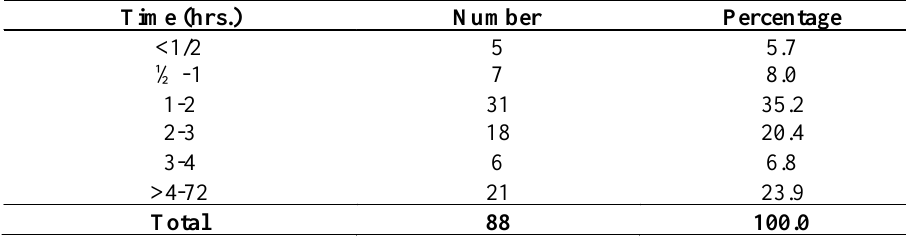
Table III : Time interval between delivery and arrival at hospital Time (hrs.)